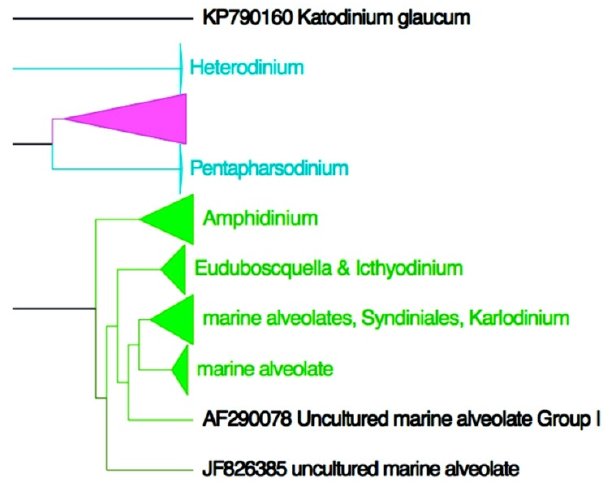
Figure 4. Enlarged view of Clade 1.